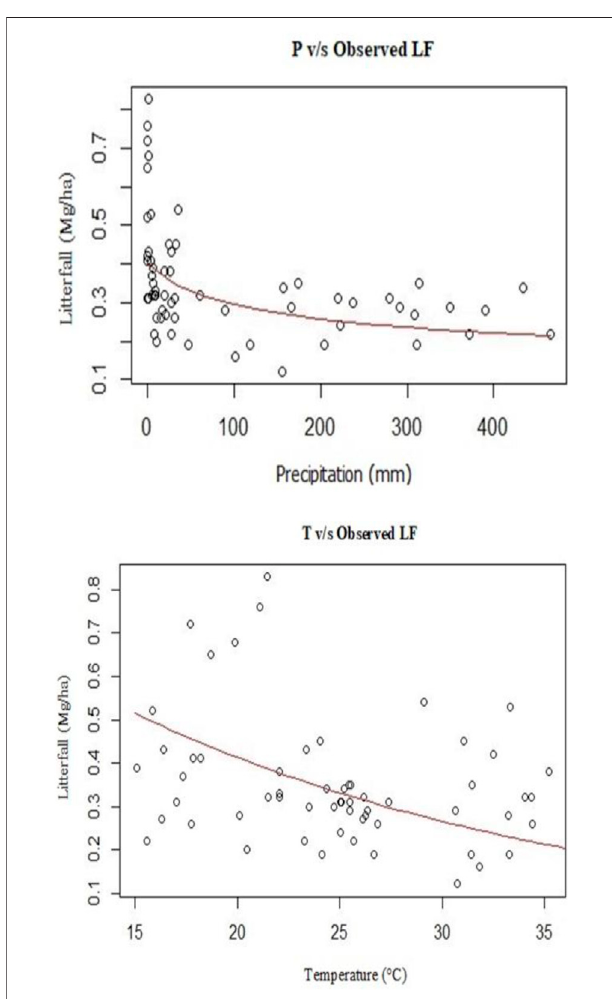
FIGURE 9 | Scatter plot of the selected parameters v/s litterfall. (A) : Mean precipitation (mm) v/s litterfall. Observed LF was predicted by model M1. The curve gives the predicted litter fall over the range of precipitations as per the model M1. (B) : mean temperature ( ° C) v/s litterfall. observed LF was predicted by model M2. The curve gives the predicted litter fall over the range of temperature as per the model M2.